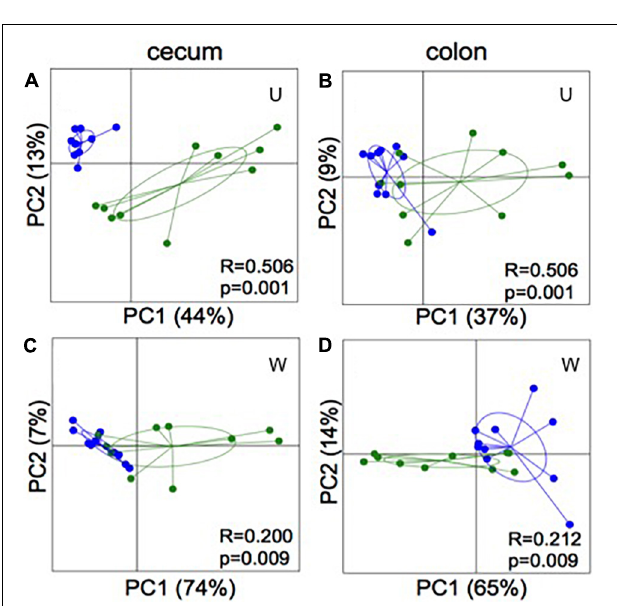
FIGURE 4 | 16S rRNA gene amplicon sequencing of cecum (A,C) and colon (B,D) content of mice inoculated with microbiota from foals fed either a test supplement enriched with oligosaccharides (green) or a control diet (blue). PCoA plots based on weighted (W) and unweighted (U) UniFrac distances show significant separation (ANOSIM: bottom right coroner) between groups in both compartments of the